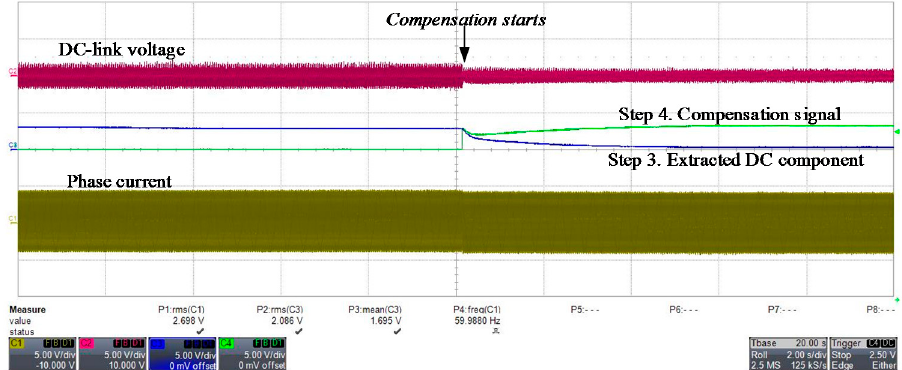
Figure 13. Experimental results of the dynamic characteristic of the proposed DC compensation algorithm.